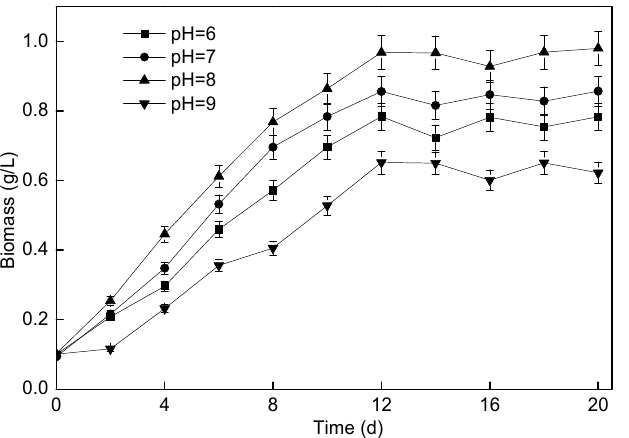
Figure 7. Changes in P. helgolandica tsingtaoensis biomass concentration under different influent